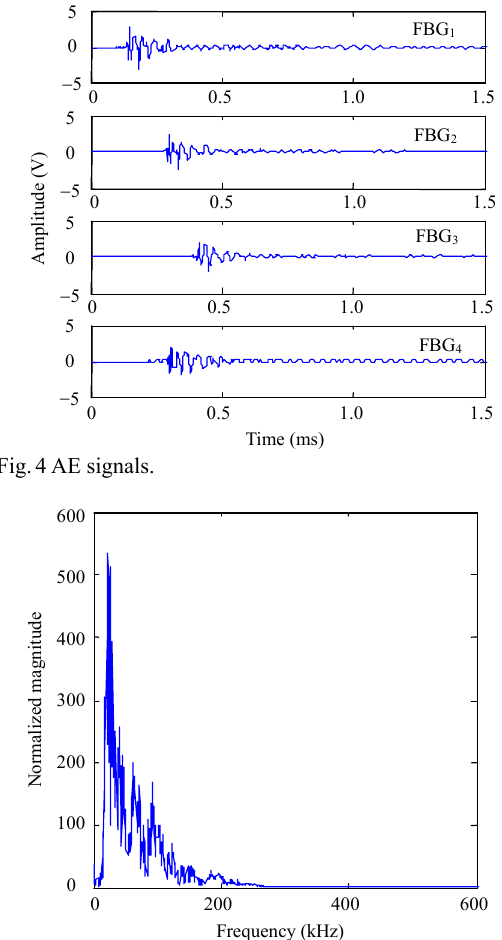
Fig. 5 Frequency spectrum of AE signals.